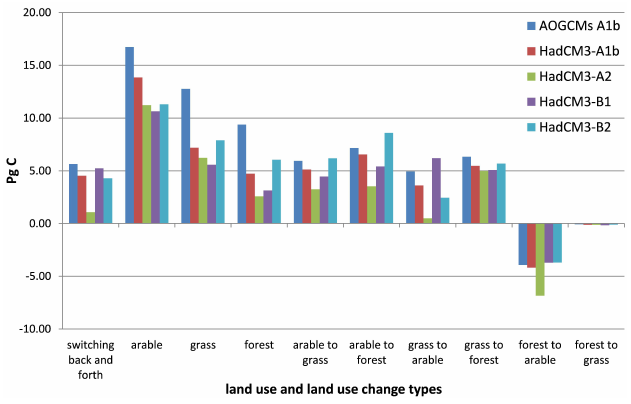
Fig. 5. Contribution of land use and land use change to global SOC stock changes (from 1971 to